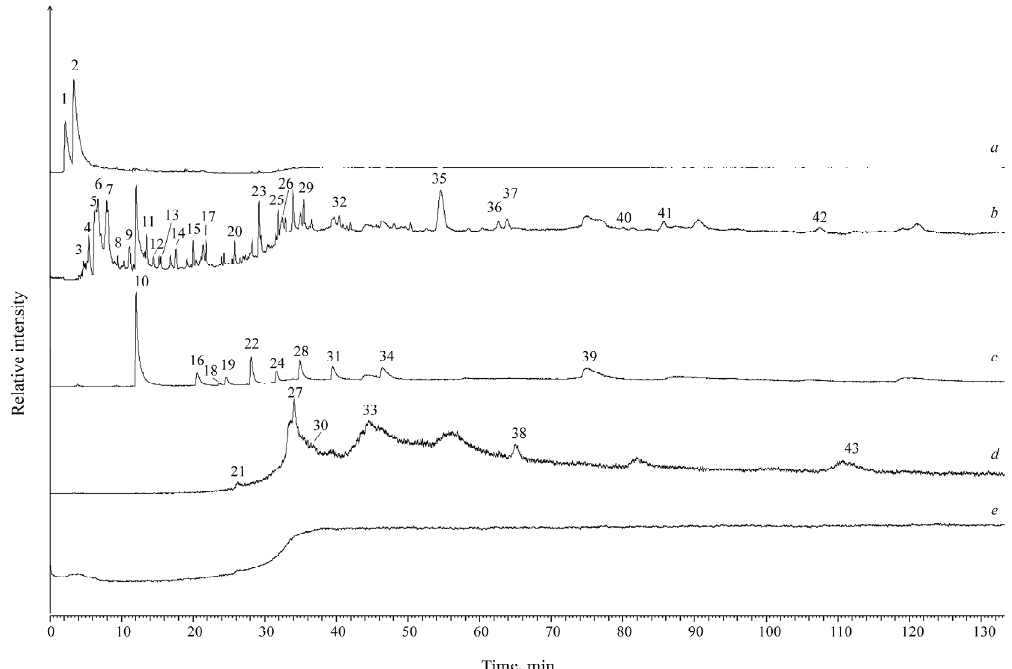
Figure 5. Results of GC ‐ MS analysis of volatile components extracted from the central cordierite zone of the Muzkol metamorphic complex, Tajikistan (sample 1). Chromatogram a is a total ion current